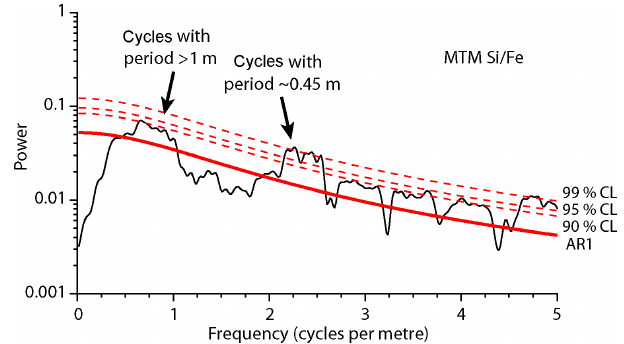
Figure 4. Multitaper method (MTM) power spectra for Si / Fe ra- tios; highlighted are spectral peaks equivalent to cycles with a pe- riod >1 and ∼ 0.45m. Autoregressive spectral analysis undertaken using the mtmML96 routine of the “astrochron” software package (Meyers, 2014); dotted red lines represent the 90, 95 and 99% con- fidence levels